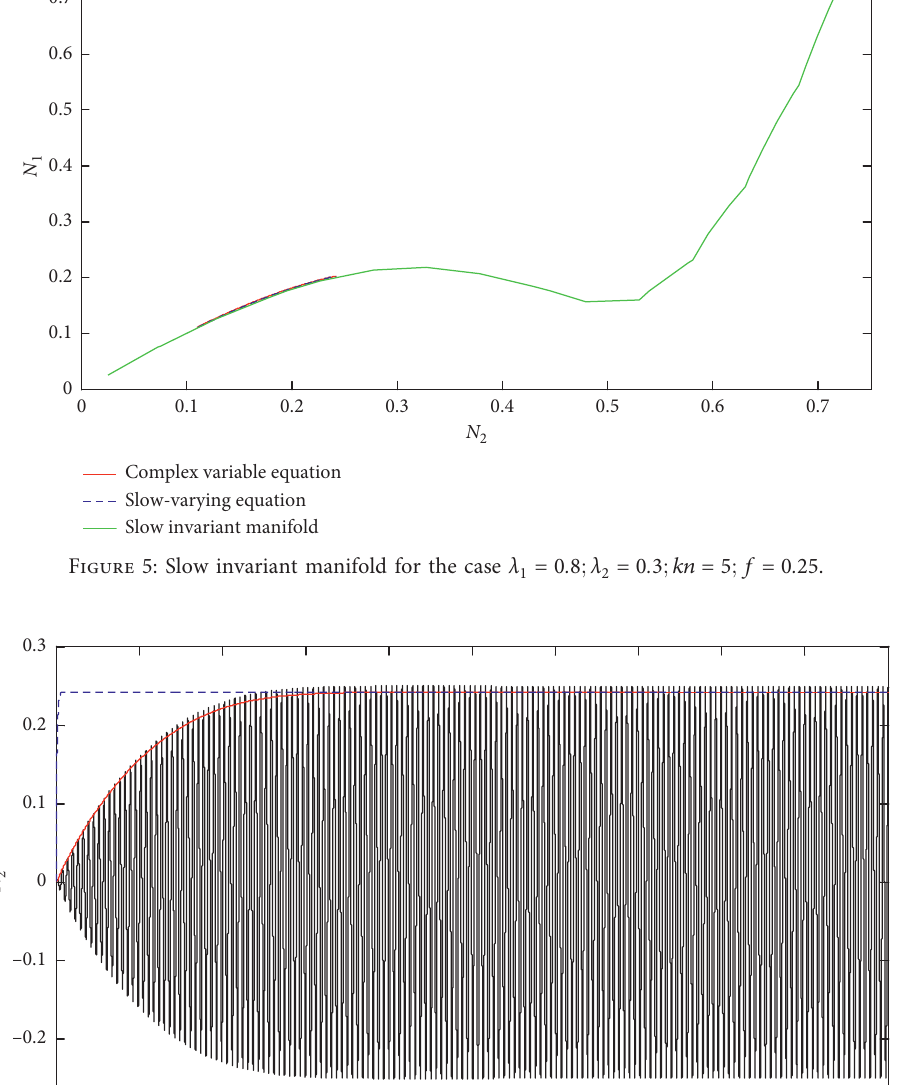
Figure 6: Time-history curves of nonlinear energy sink. The dashed line refers to the steady-state response of the slow-varying equation. � 0 . 8 ; λ � 0 . 3 ; kn � 5 ; f � 0 . System parameters: λ 1 2